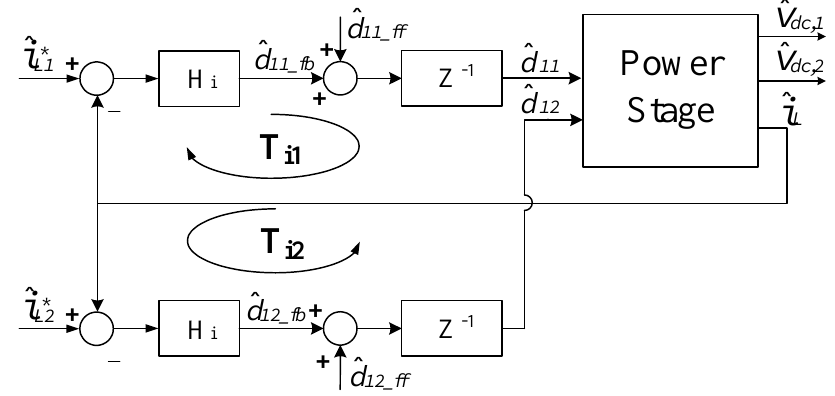
Figure 3. Small signal current-loop control block diagram for grid current control.